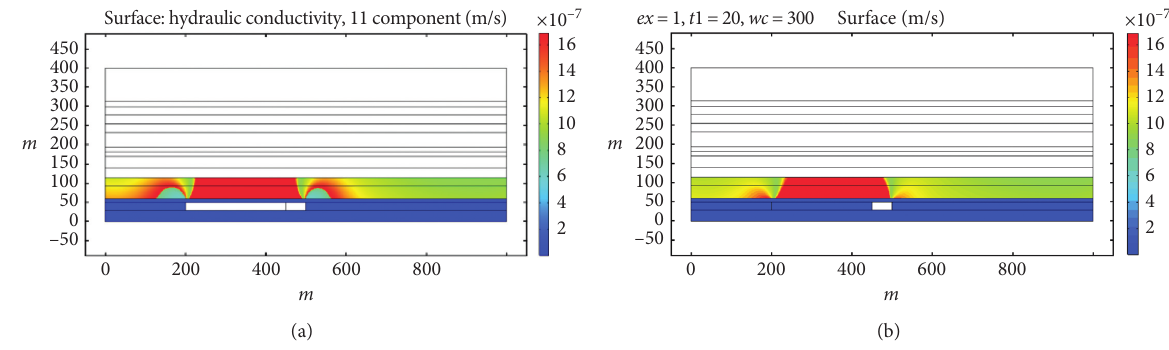
Figure 7: Permeability changes when roof management is not used. (a) Direct roof caving method. (b) Filling mining